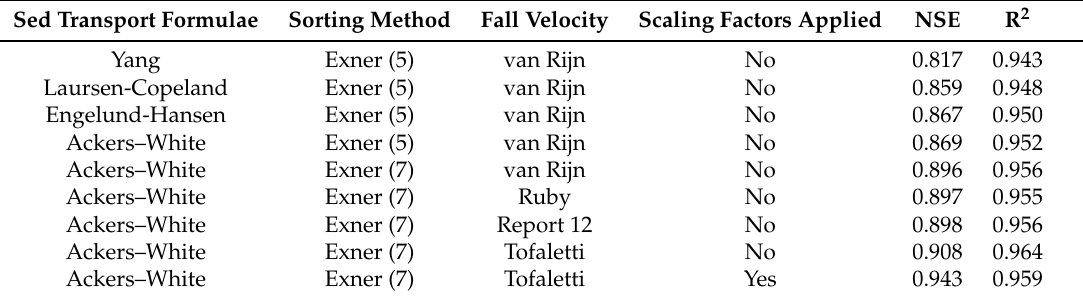
Figure 7. Comparison of observed and SRC simulated bed levels during calibration for 2013: ( a ) along the Tarbela Reservoir; ( b ) R/Line 66; ( c ) R/Line 41; ( d ) R/Line 25; ( e ) R/Line 2. Table 5. Statistical performance of HEC-RAS with SRC sediment series by the input of different transport formulae and varying